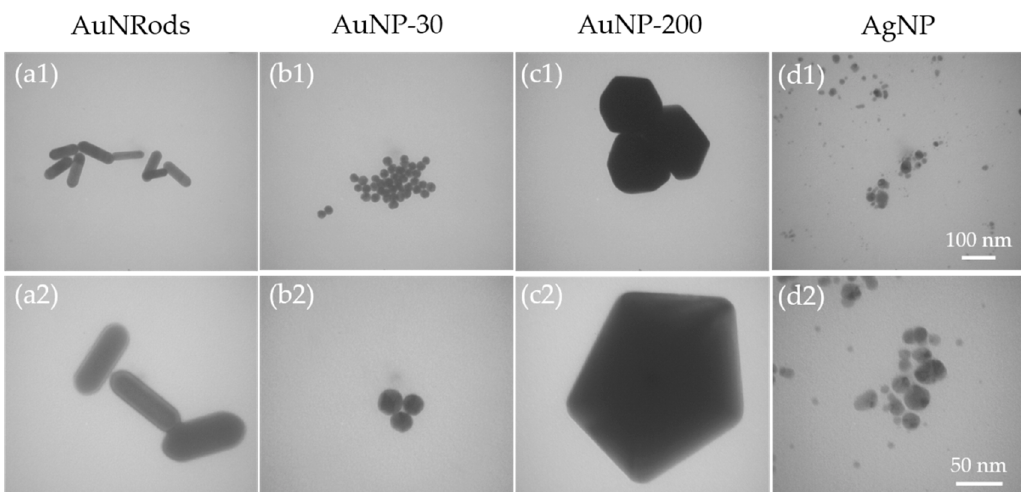
Figure 1. Representative transmission electron microscopy (TEM) images of metallic nanoparticles (mNP) in pure water. ( a1 , a2 ) gold rods (AuRods); ( b1 , b2 ) spherical 30 nm gold nanoparticles (AuNP-30); ( c1 , c2 ) spherical 200 nm gold nanoparticles (AuNP-200); ( d1 , d2 ) spherical 20 nm silver nanoparticles (AgNP). Scale bar in upper row: 100 nm. Scale bar in lower row: 50 nm.